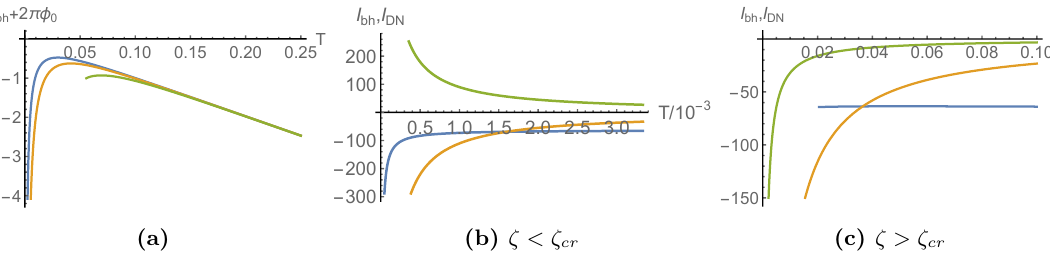
Figure 18. (a) Plot of I bh + 2 πφ 0 as a function of T for different ζ , where blue is for ζ < ζ cr , yellow is for ζ = ζ cr , and green is for ζ > ζ cr ; (b) and (c) are both plots of I bh and I DN as a function of T , where blue curve is for I bh , yellow curve is for I DN with E DN < E DN , max and green is for I DN with E DN > E DN , max . We set 2 φ b = 1 and S 0 = 10 in these